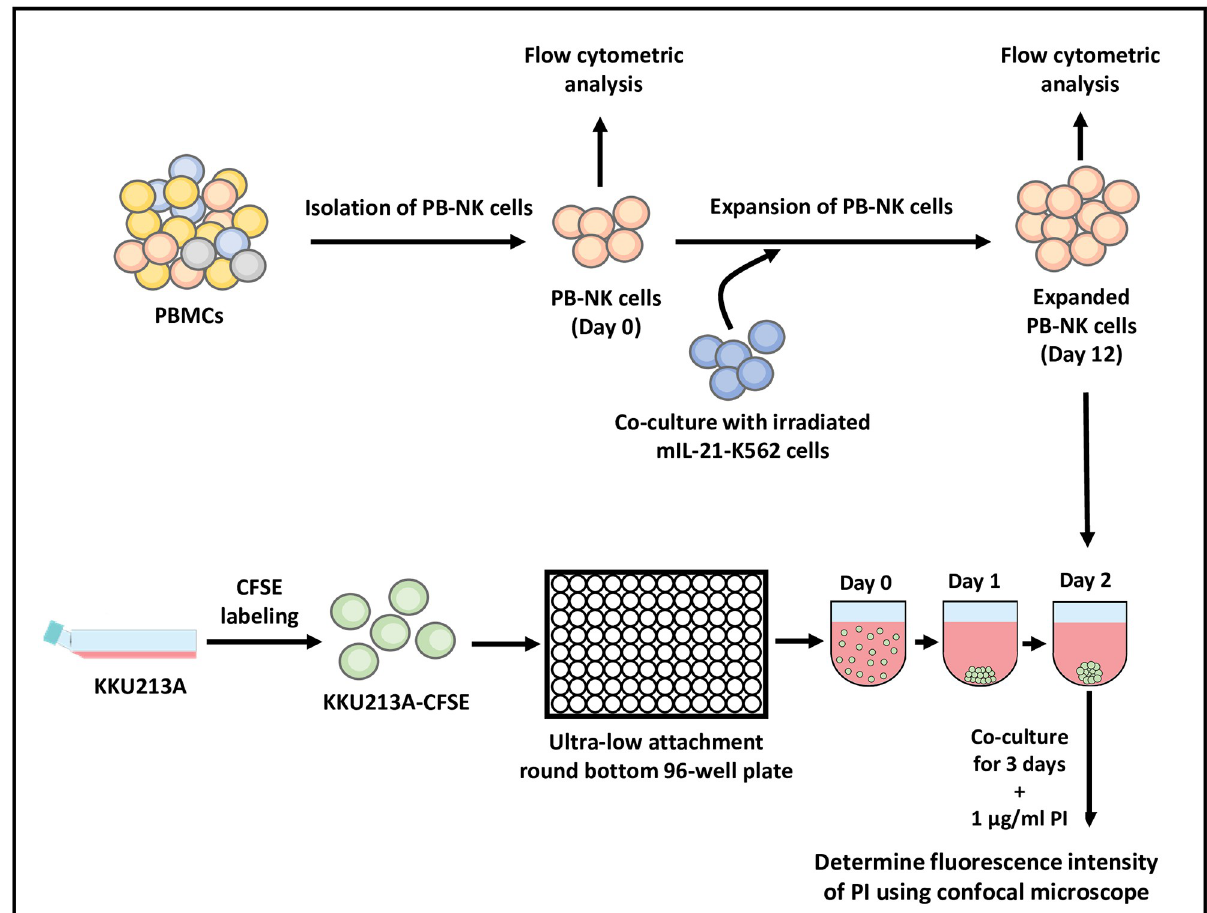
Fig 1. Schematic diagram of cytotoxicity assay using PB-NK cells toward the 3D tumor spheroids.